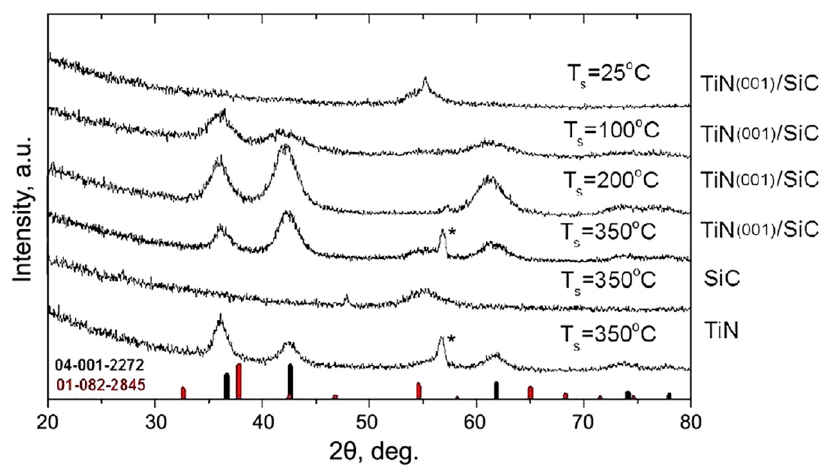
Figure 18. Cathodic and anodic Tafel polarization curves for CrN/ZrN multilayer coatings with different number of bilayers (1, 8, 15, 30) [147].